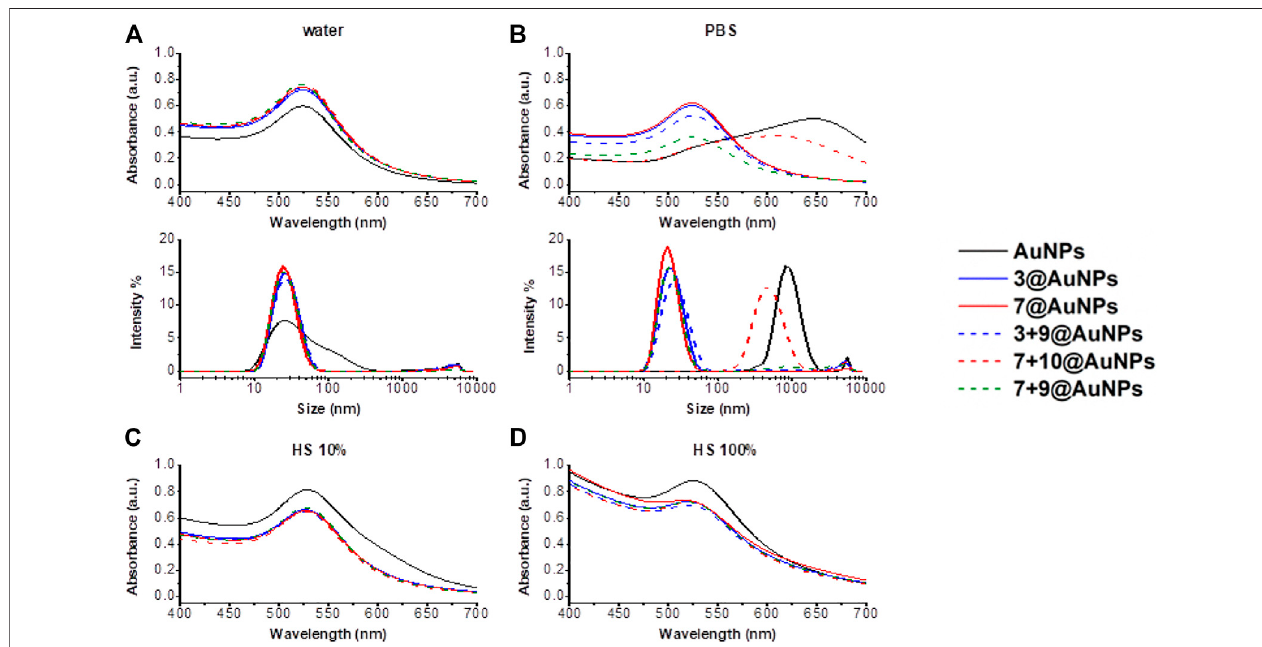
FIGURE6| Stabilitystudyindifferentmediums.Absorptionspectraandsizedistributionbyintensityin (A) water, (B) PBS1Xandabsorptionspectrain (C) HS10% in water and (D) HS 100% of AuNPs (black) and functionalized-AuNPs with peptides 3 (blue), 7 (red), 3 + 9 (dash blue), 7 + 10 (dash red), and 7 + 9 (dash green). Mean DLSresultsaregivenforthreedifferentmeasurements.A)Thehydrodynamicdiameterinwaterisfound31.0 ± 0.6 nm PdI0.4 ± 0.01forAuNPs,25.5 ± 0.3 nm PdI0.2 ± 0.002 for 3 @AuNPs, 23.7 ± 0.3 nmPdI 0.2 ± 0.03for 7 @AuNPs, 26.3 ± 0.2 nmPdI0.3 ± 0.02for 3 + 9 @AuNPs, 23.8 ± 0.2 nm PdI0.2 ± 0.02for 7 + 10 @AuNPs, and 23.8 ± 0.4 nm PdI 0.2 ± 0.02 for 7 + 9 @AuNPs. B) The hydrodynamic diameter in PBS 1X is found 973.1 ± 14.2 nm PdI 0.4 ± 0.05 for AuNPs, 22.4 ± 0.6 nm PdI 0.3 ± 0.06 for 3 @AuNPs, 28.5 ± 0.6 nm PdI 0.2 ± 0.05for 7 @AuNPs, 26.6 ± 0.6 nm PdI 0.3 ± 0.02 for 3 + 9 @AuNPs, 470 ± 35.9 nm PdI0.2 ± 0.02 for 7 + 10 @AuNPs,